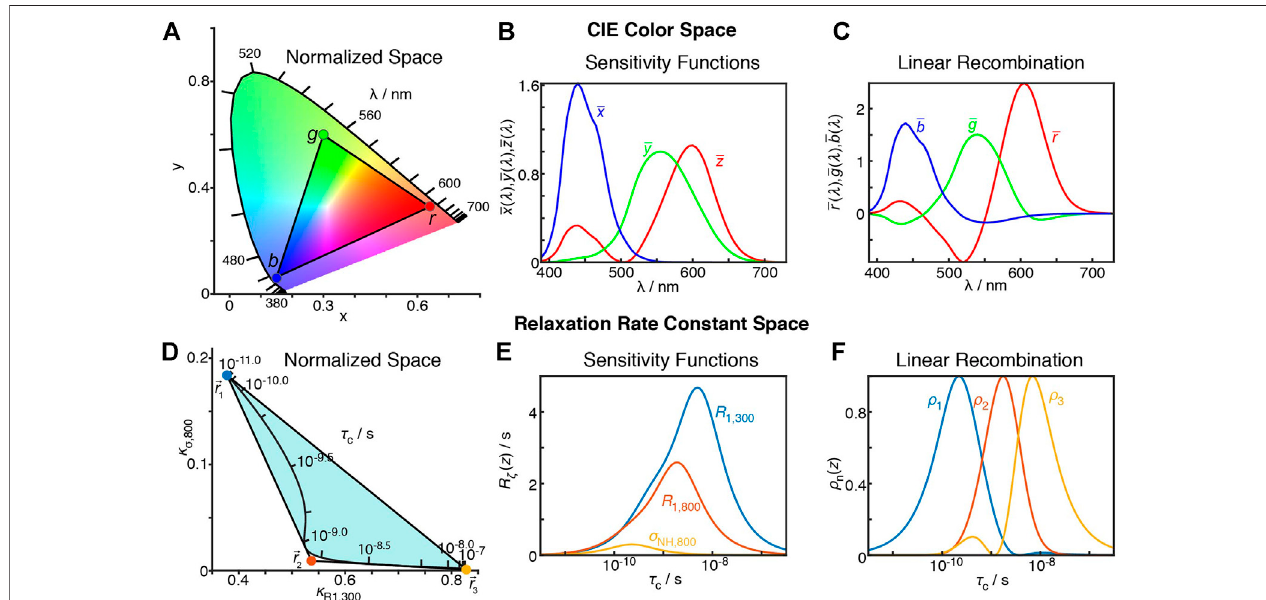
FIGURE 10 | Similarity between the CIE XYZ colorspace and the relaxation rate constant space. (A) plots the XYZ colorspace, black lines indicate where single wavelengths fall in the colorspace ( z not shown, space isnormalized such that x + y + z (cid:2) 1). Points connected by atriangle indicate the de fi nition of red, green, and blue colors as de fi ned by the sRGB standard (Anderson et al., 1996). (B) plots the sensitivity of the x (cid:10) λ (cid:11) , y (cid:10) λ (cid:11) , and z (cid:10) λ (cid:11) color matching functions as a function of wavelength ( λ ). (C) plotssRGBsensitivitiesresultingfromtransformationfromtheXYZtosRGBspaces.Pointsconnectedbytrianglescorrespondtode fi nitionsof (cid:2) r 1 , (cid:2) r 2 ,and (cid:2) r 3 that de fi ne the detector space. (D) shows the normalized relaxation rate space for 13 C R 1 at 300 and 800 MHz and H – C NOE at 800 MHz. (E) shows the sensitivities of eachoftheseexperimentsafunctionofcorrelationtime. (F) showsdetectorsensitivitiesresultingfromtransformationfromtherelaxationrateconstantspacetodetector space (de fi ned by the points in (D)